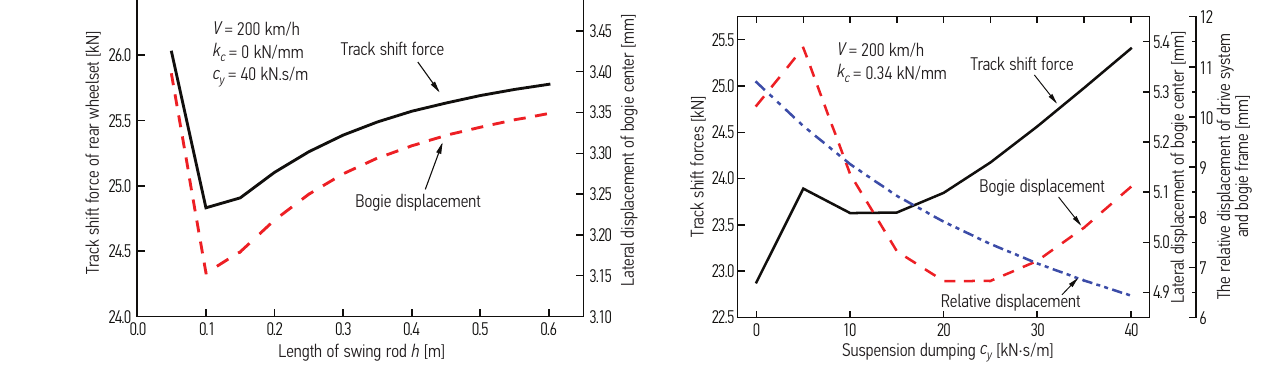
Fig. 23. The simulation results of locomotive 1 with different c